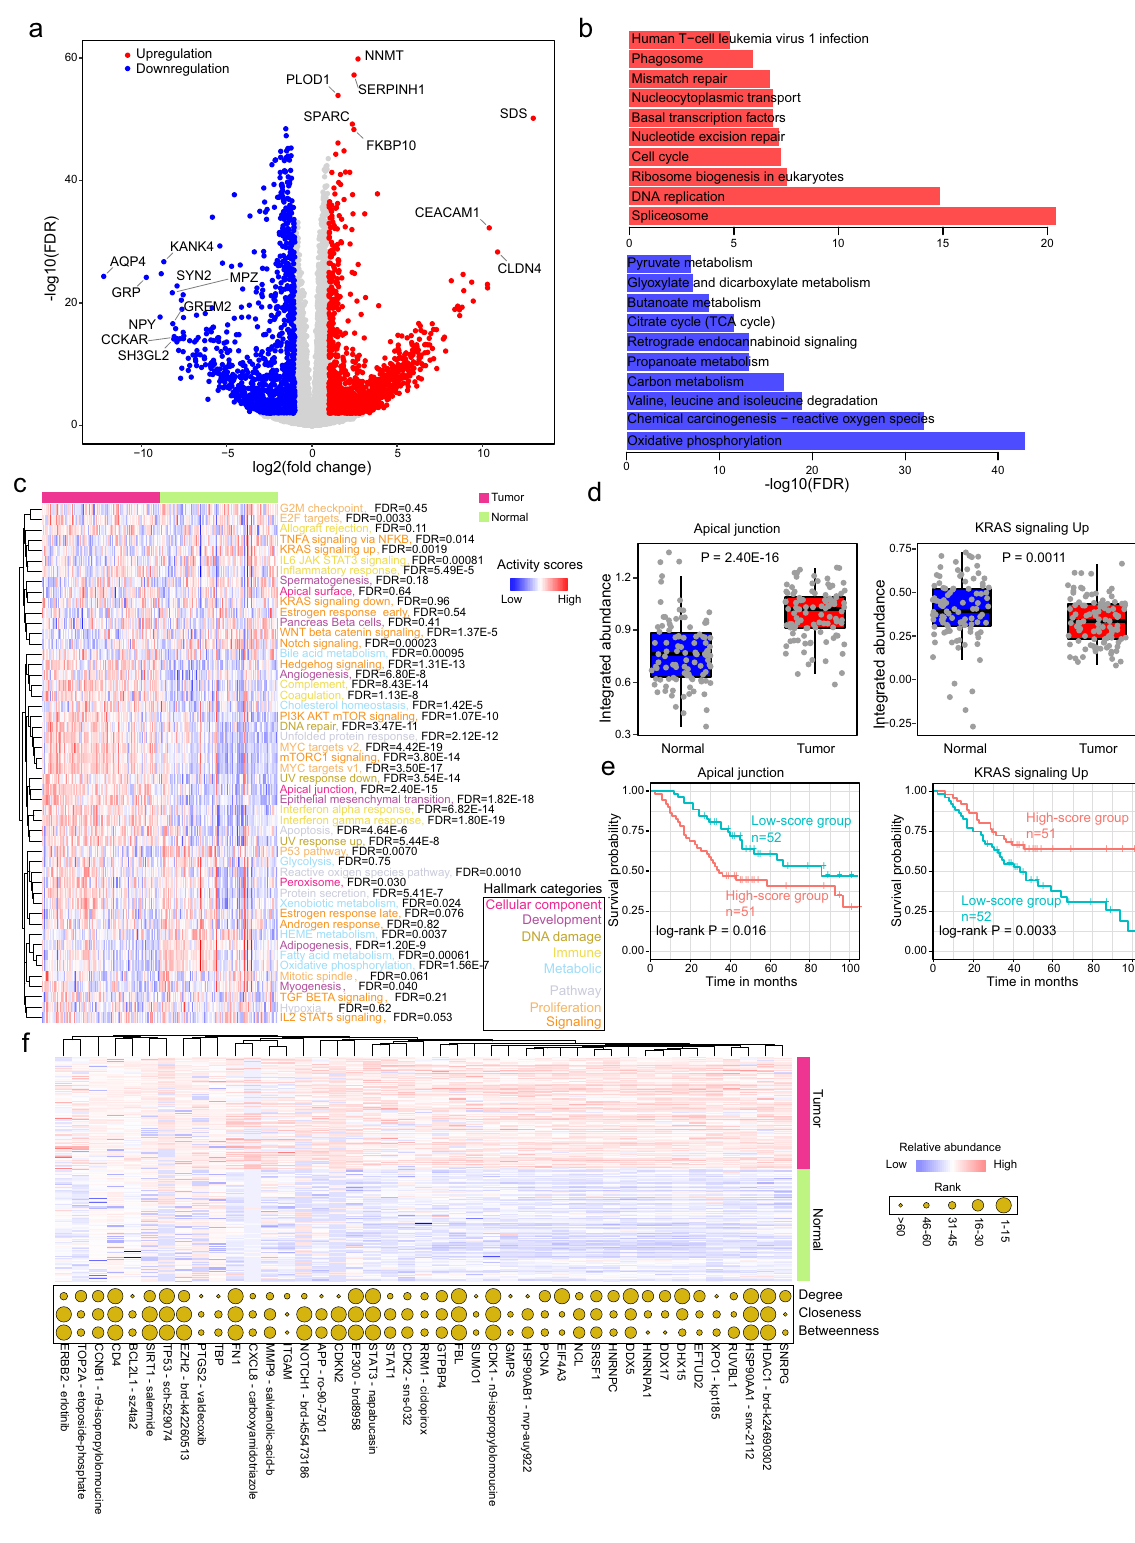
G2M checkpoint , FDR=0.45 E2F targets, FDR=0.0033 Allograft rejection, FDR=0.11 TNFA signaling via NFKB, FDR=0.014 KRAS signaling up , FDR=0.0019 IL6 JAK STAT3 signaling , FDR=0.00081 Activity scores Inflammatory response, FDR=5.49E-5 Spermatogenesis, FDR=0.18 Apical surface, FDR=0.64 Low High KRAS signaling down, FDR=0.96 Estrogen response early, FDR=0.54 Pancreas Beta cells, FDR=0.41 WNT beta catenin signaling, FDR=1.37E-5 Notch signaling, FDR=0.00023 Bile acid metabolism, FDR=0.00095 Hedgehog signaling, FDR=1.31E-13 Angiogenesis, FDR=6.80E-8 Complement, FDR=8.43E-14 FDR=3.50E-17Coagulation, FDR=1.13E-8 Cholesterol homeostasis, FDR=1.42E-5 PI3K AKT mTOR signaling, FDR=1.07E-10 DNA repair, FDR=3.47E-11 Unfolded protein response, FDR=2.12E-12 MYC targets v2, FDR=4.42E-19 mTORC1 signaling, FDR=3.80E-14 FDR=0.75MYC UV response down, FDR=3.54E-14 Apical junction, FDR=2.40E-15 Epithelial mesenchymal transition, FDR=1.82E-18 Interferon alpha response, FDR=6.82E-14 Interferon gamma response, FDR=1.80E-19 Apoptosis, FDR=4.64E-6 UV response up, FDR=5.44E-8 P53 pathway, FDR=0.0070 FDR=0.00061Glycolysis, Reactive oxigen species pathway, FDR=0.0010 Peroxisome, FDR=0.030 Protein secretion, FDR=5.41E-7 Xenobiotic metabolism, FDR=0.024 Cellular component Estrogen response late, FDR=0.076 Development Androgen response, FDR=0.82 HEME metabolism, FDR=0.0037 DNA damage Adipogenesis, FDR=1.20E-9 Immune FDR=0.040Fatty acid metabolism, Oxidative phosphorylation, FDR=1.56E-7 Metabolic Mitotic spindle ， FDR=0.061 FDR=0.053Myogenesis ， Pathway TGF BETA signaling ， FDR=0.21 Proliferation Hypoxia ， FDR=0.62 IL2 STAT5 signaling ，